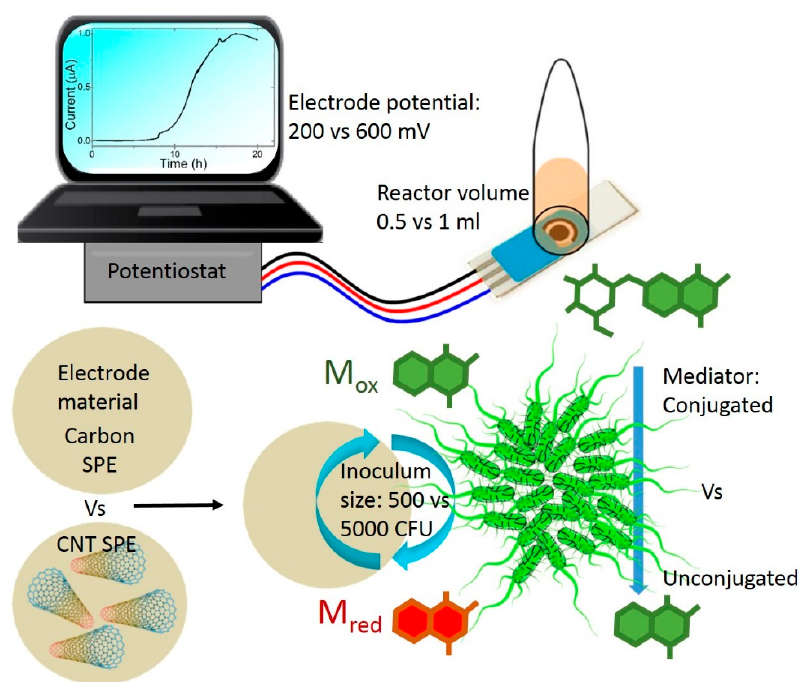
Figure 1. Conceptual experimental approach applied in the Design of Experiments (DoE) study which examined the effect of electrode potential, reactor volume, electrode material, inoculum size, mediator type on detection time. DoE experimental designs typically involve holding each factor at a high or low level. For non-continuous variables, in this case the electrode material and mediator type, ‘high’ and ‘low’ were arbitrarily assigned. A representative raw data output for each of the 32 DoE trials is shown in the laptop graphic on the top left.